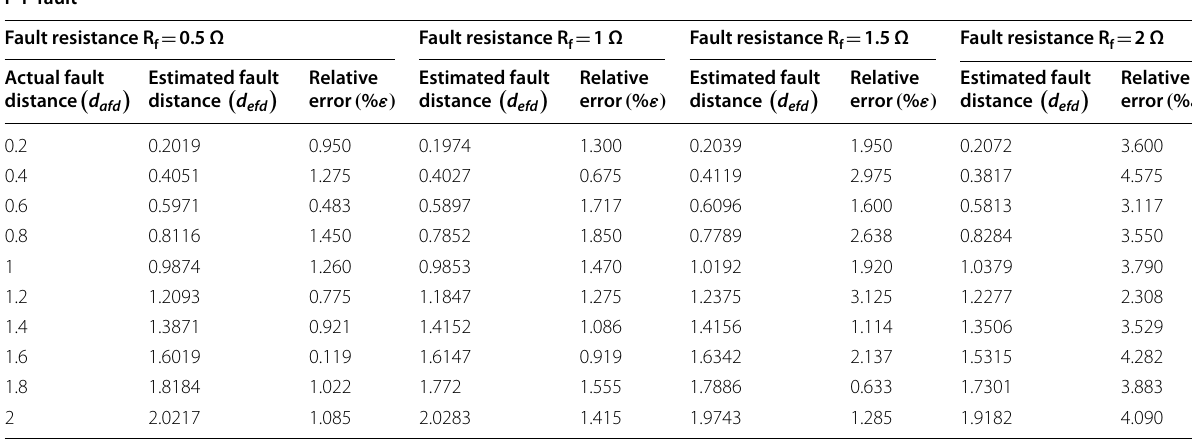
Table 11 P-P fault distance estimation using FF-RLS algorithm P‑P fault Fault resistance R f 0.5 =